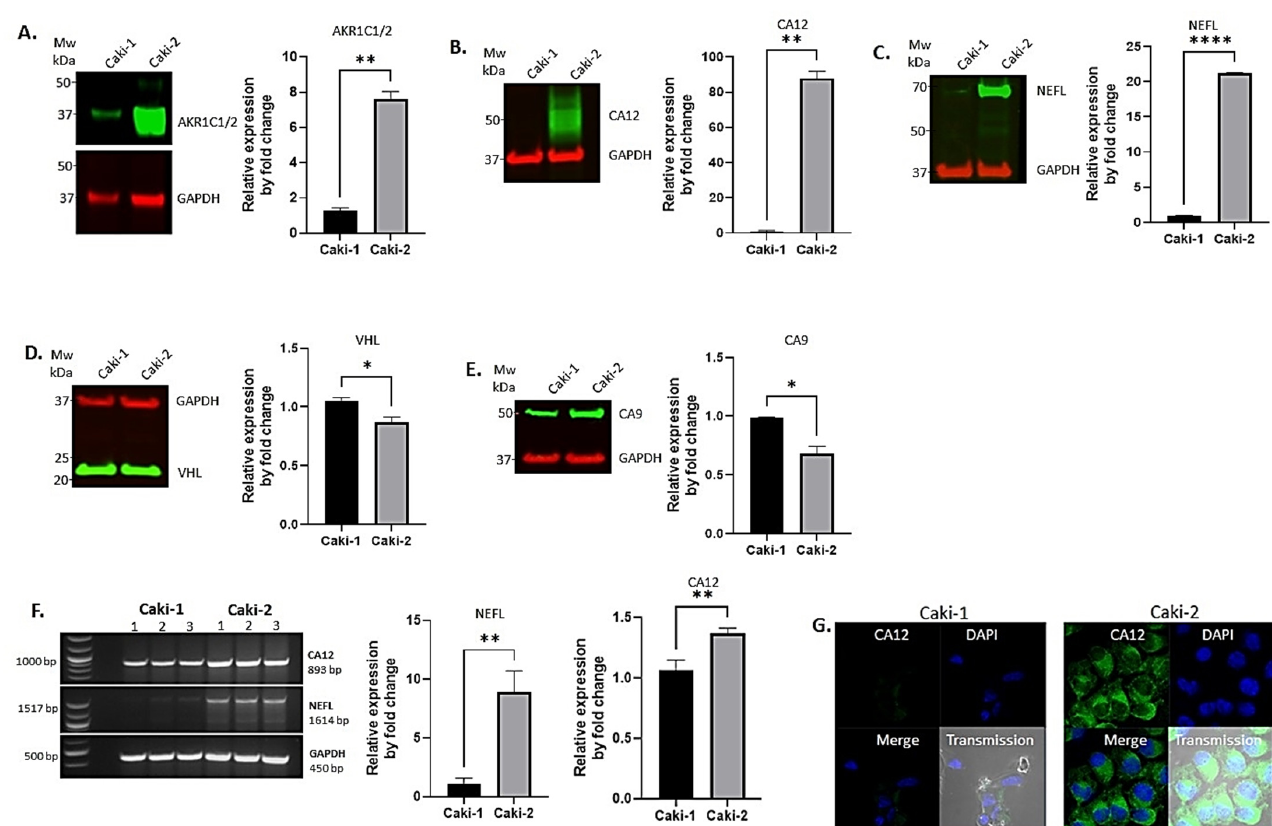
Figure 1. Differential expression of proteins in Caki-1 and Caki-2 cells. ( A ) Western blot detection and validation of expression profiles of target proteins including ( A ) AKR1C1/2, ( B ) CA12, ( C ) NEFL, ( D ) VHL, and ( E ) CA9. GAPDH was used as a western blot loading control. The expression-fold change of the proteins is based on normalization by individual GAPDH values. There is a very significant enhanced expression of AKR1C1/2 ( p = 0.0023), CA12 ( p = 0.0011), and NEFL ( p = 0.0001) in Caki-2 versus Caki-1 cells. The expression levels of VHL and CA9 differ marginally amongst the two cells ( p ≤ 0.05). ( F ) Semi quantitative mRNA expression of CA12 and NEFL in Caki-1 versus Caki-2 cells. cDNA was synthesized from total mRNA extracted from the two cell lines and used for RT-qPCR to evaluate their relative expression levels in the two cell lines. qPCR reactions amplifying CA12 (893 b.p.), NEFL (1614 b.p.), and GAPDH (450 b.p.) in the two cell lines were analyzed via gel electrophoresis on 2% agarose gels containing EtBr for DNA visualization under UV. Relative band intensities were measured and used for quantitation with GAPDH as a control for normalization. There is a significantly enhanced expression of CA12 and NEFL transcripts in Caki-2 compared to Caki-1 cells ( p ≤ 0.05). ( G ) Immunofluorescence confocal microscopy detection of CA12 in the two cell lines. The detection and visualization of CA12 are significantly higher in Caki-2 cells. For the bar graphs, significant differential expression profiles are depicted using asterisks corresponding to the following thresholds * ( p < 0.05), ** ( p < 0.005) and **** ( p <